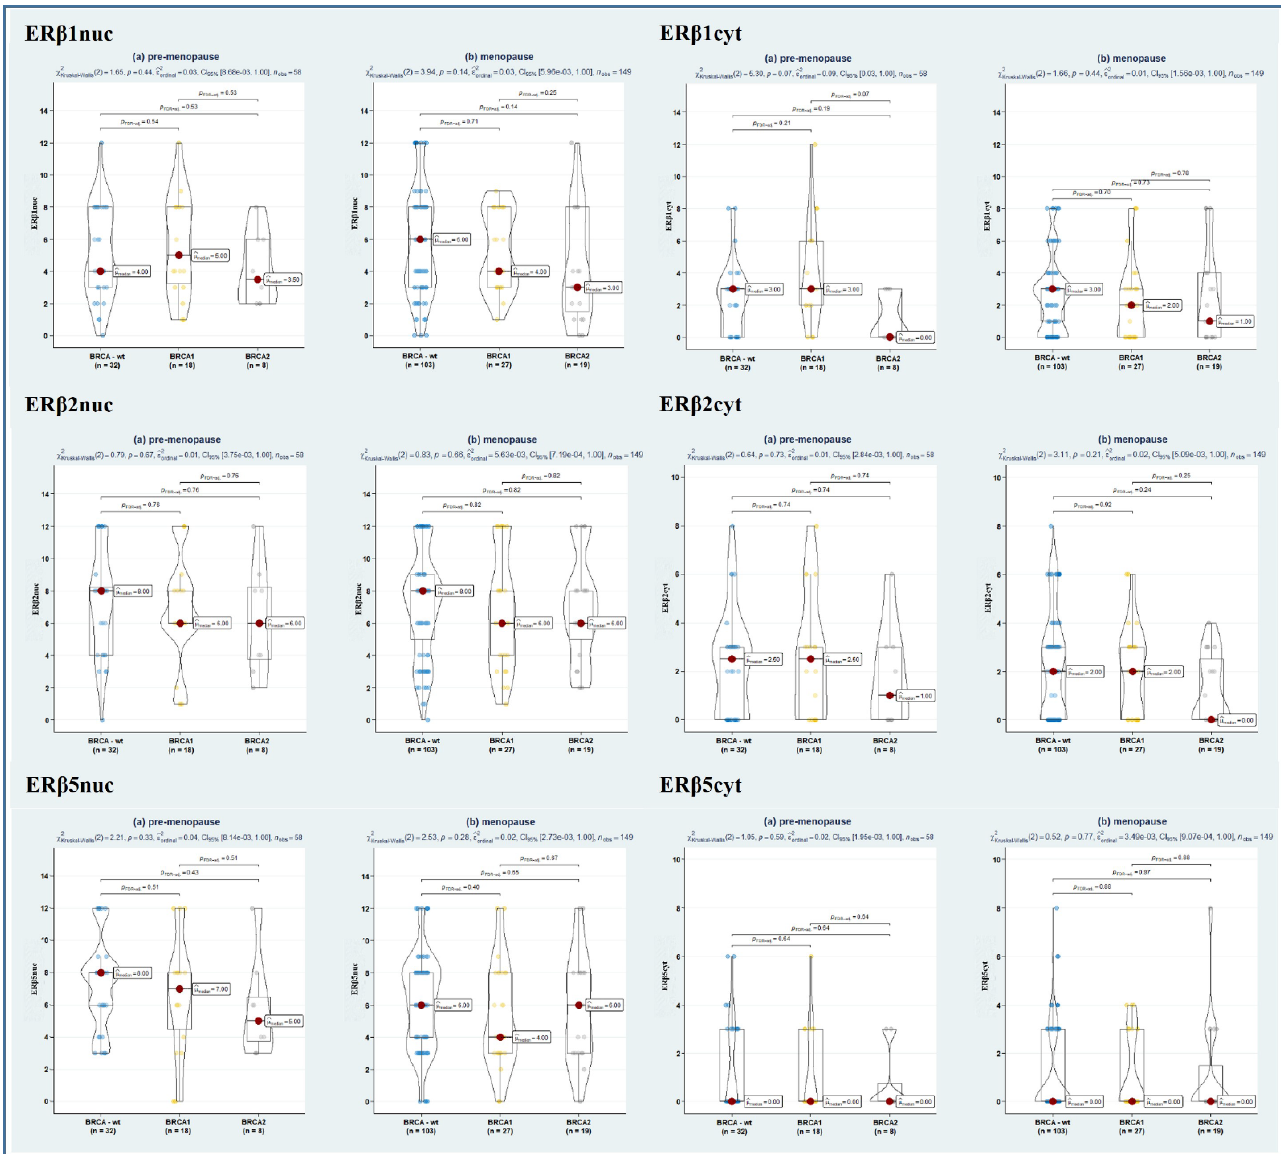
Figure 3. Violin plots depicting the relationship between ER β 1nuc ( upper left panel ), ER β 1cyt ( upper right panel ), ER β 2nuc ( middle left panel ), ER β 2cyt ( middle right panel ), ER β 5nuc ( lower left panel ), and ER β 5cyt ( lower right panel ) in BRCA-wt, BRCA1, and BRCA2 mutated women according to menopausal status. Both overall and pairwise comparisons are reported, with FdR correction. Blue, yellow and grey dot respectively represents BRCA-wt, BRCA1 and BRCA2 patients pertaining that score of molecular marker.